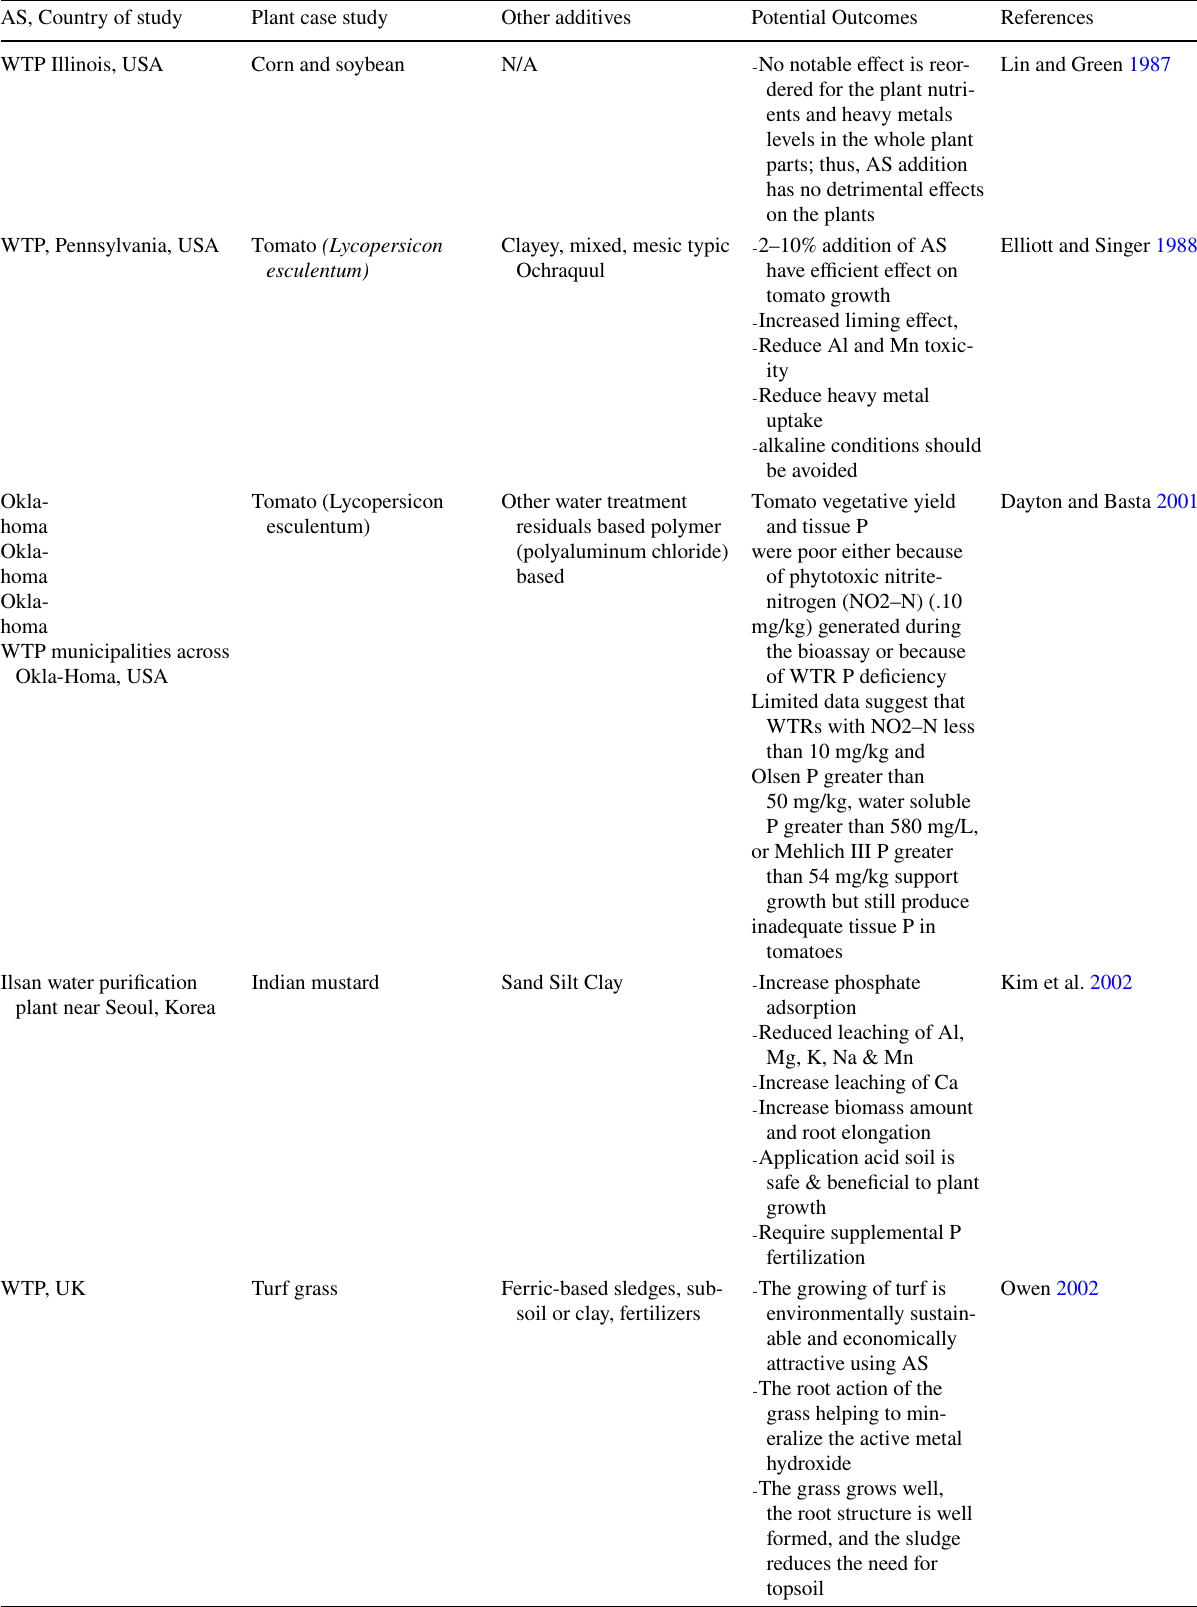
Table 4 Summarized results of alum sludge application in agriculture sector* AS, Country of